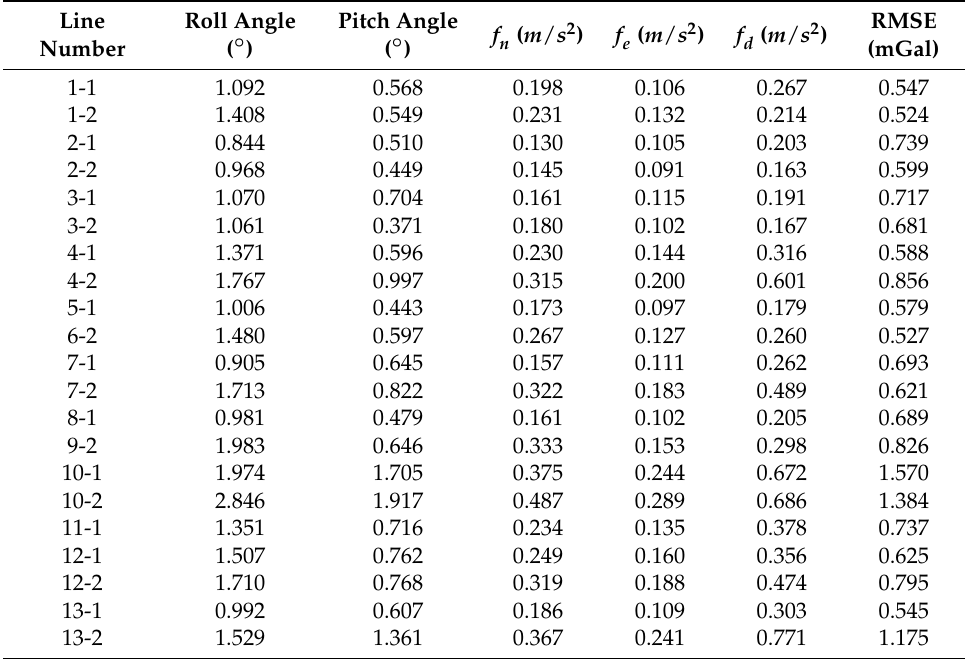
Table 3. Standard deviation of five factors and internal RMSE in 21